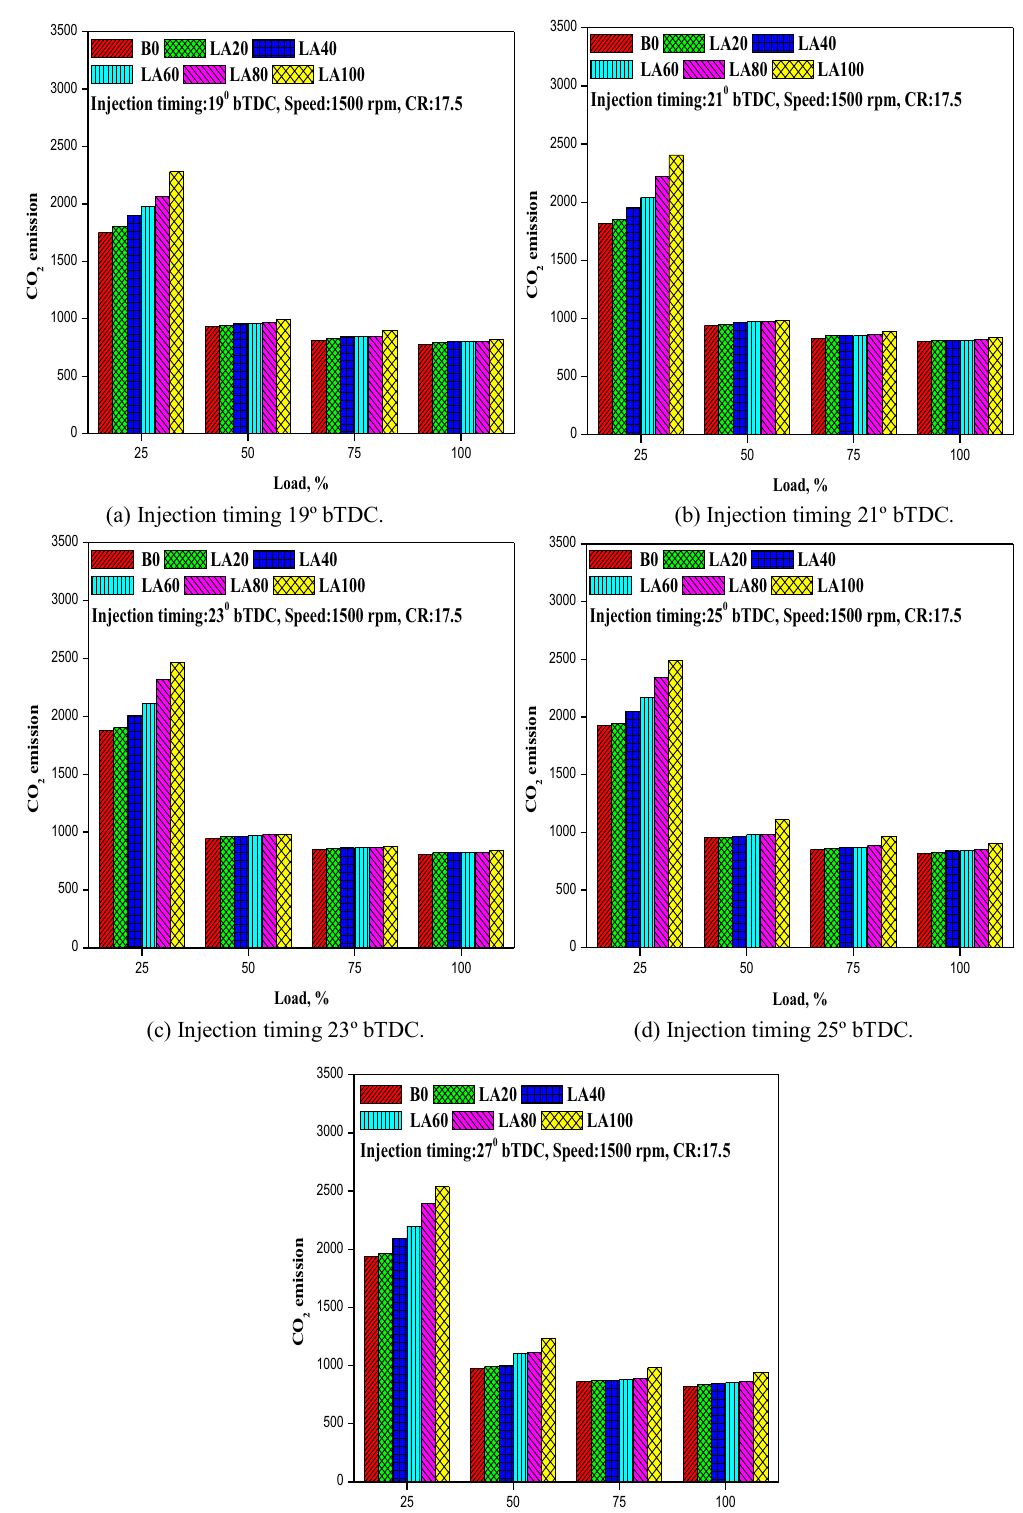
Figure 12. ( a–e ) The variation in CO 2 emision with different FITs and engine load for considered fuel